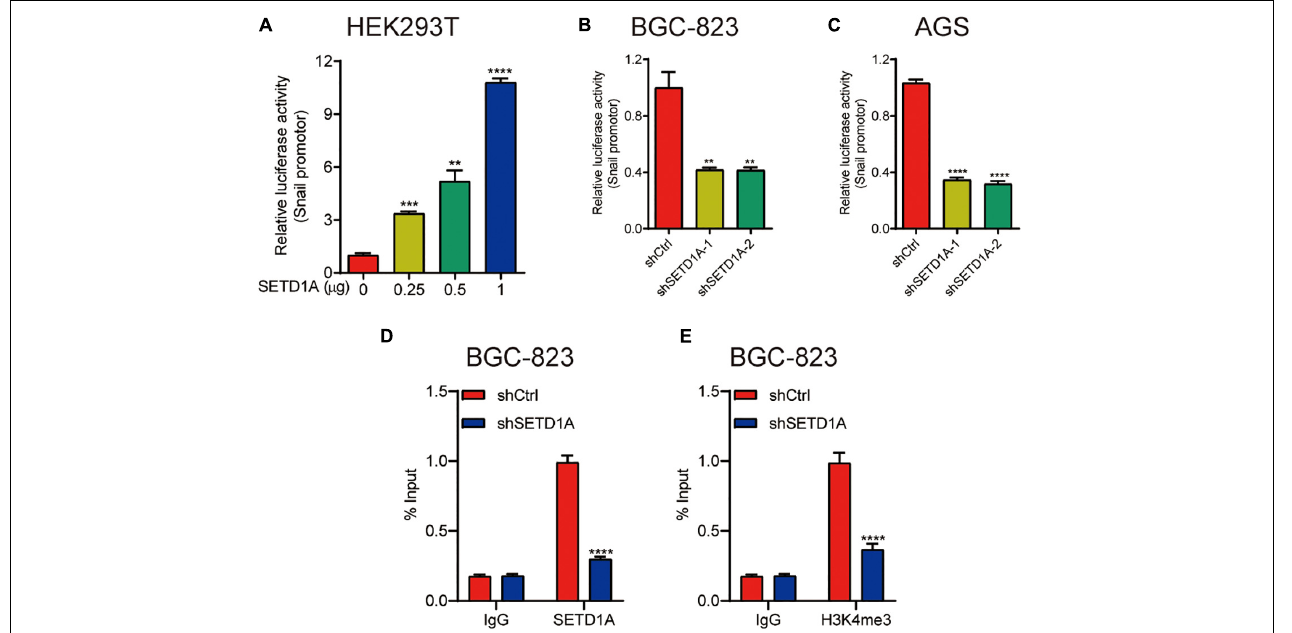
FIGURE 3 | SETD1A promote snail expression by increasing the H3K4me3 levels on the snail promoter. (A) SETD1A enhances the promoter reporter activity of snail in a dose-dependent manner in HEK293T cells. Data from three replicates are shown as the means ± SD. ** p < 0.01, *** p < 0.001, **** p < 0.0001 by Student’s t- test. (B,C) Downregulation of SETD1A decreases the promoter reporter activity of snail in BGC-823 and AGS cells. Data from three replicates are shown as the means ± SD. *** p < 0.001, **** p < 0.0001 by Student’s t -test. (D,E) Downregulation of SETD1A reduces the levels of SETD1A (D) and H3K4me3 (E) on the promoter of snail in BGC-823 cells. Data from three replicates are shown as the means ± SD. **** p < 0.0001 by Student’s t -test.